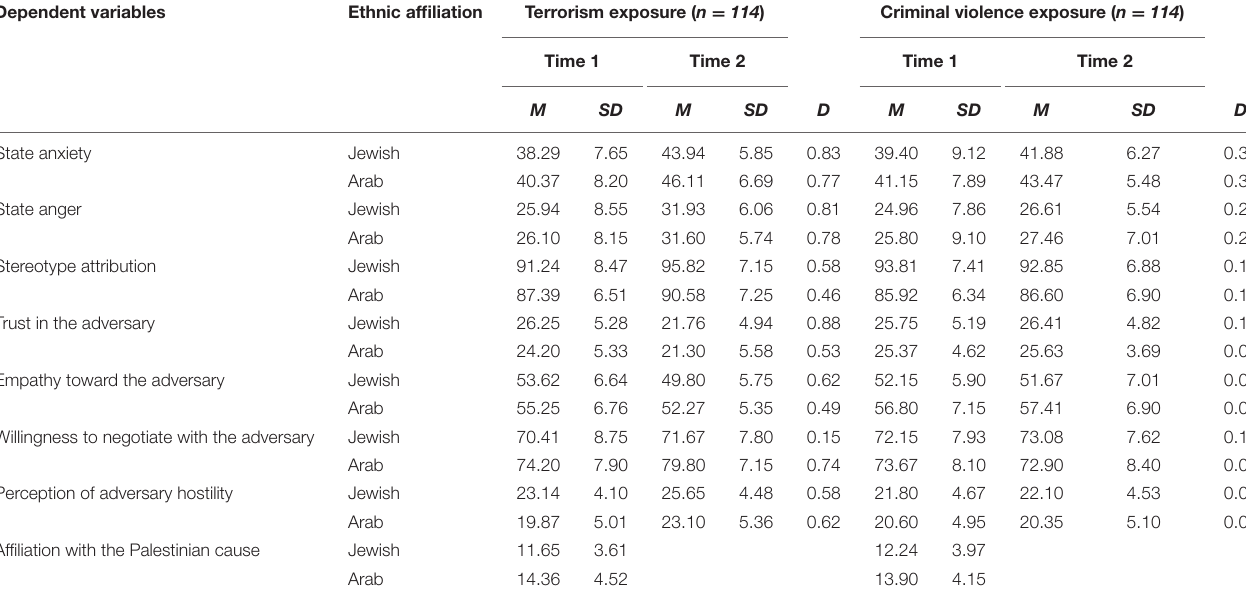
TABLE 1 | Means and standard deviations for pre- and post-test levels of the dependent variables for each type of media exposure and ethnic affiliation. Dependent